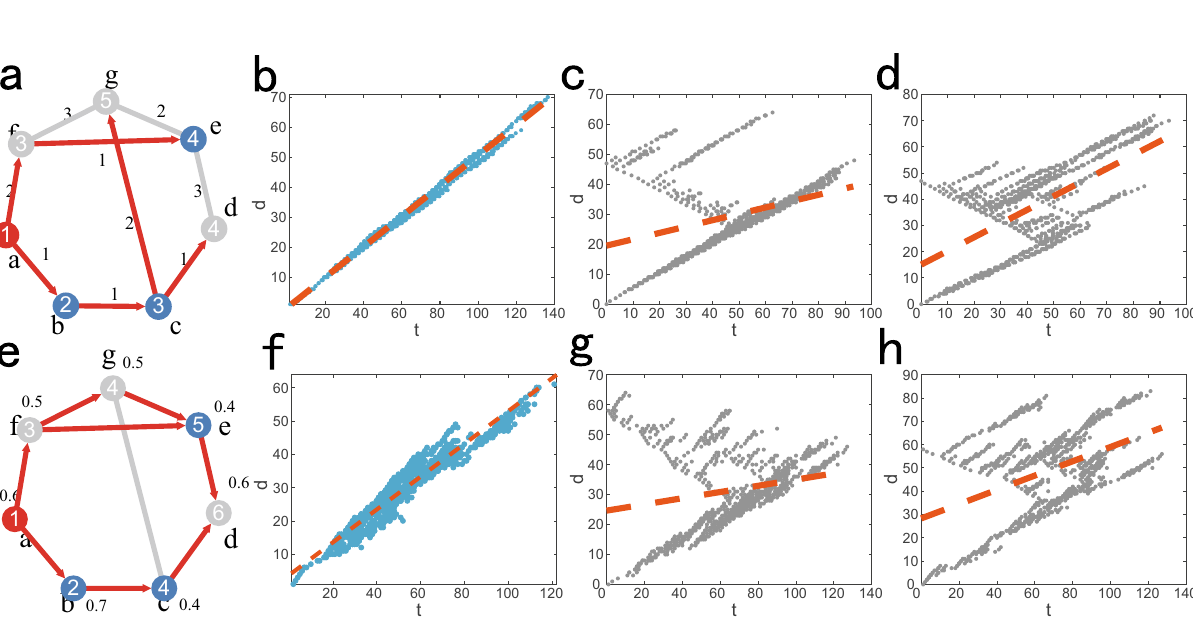
Figure 1. Property of propagation models. ( a ) is an example of diffusion dynamics in a simple network. Red nodes are sources of message and links with arrows represent the direction of message propagation. Numbers in the center of nodes are their informed time. Blue nodes are observer nodes and we will use their informed time to locate source nodes. Numbers beside links are their propagation time delay. During diffusion dynamics, message is transmitted along the shortest path. Source node a begin to spread message at initial time t a = 1 , nodes b , c , d , e , f and g receive message from their neighbour nodes at informed time t b = 2 , t c = 3 , t d = 4 , t e = 4 , t f = 3 , t g = 5 respectively. ( b )–( d ) are positive correlation between inform time of nodes and geodesic distance between nodes and source. We execute experiment on ER random network with n = 1000 and the average degree is � k � = 2 . The sources are selected randomly. Abscissa is inform time of nodes and ordinate is geodesic distance between nodes and sources. The orange line is the fitting result. ( b ) is the result of diffusion dynamics with one source, the time delay of edges follows Gaussian distribution N ( u , σ 2 ) with u = 2 and σ = 0.25 . ( c ) and ( d ) are the results with two sources at once, ( c ) corresponds to the first source and ( d ) corresponds to the second one. (e) is an example of the SI dynamics. Numbers beside nodes are informed rate. Source node a begin to spread message at initial time t a = 1 , nodes b , c , f , g are infected by their neighboring nodes with their respective informed rate. Node e is infected by nodes f and g with probability 0.64, node d is infected by nodes e and c with probability 0.84. ( f )–( h ) are positive correlation between inform time of nodes and geodesic distance between nodes and source of SI dynamics on ER random network. We set informed rate as (cid:31) = 0.5 for SI